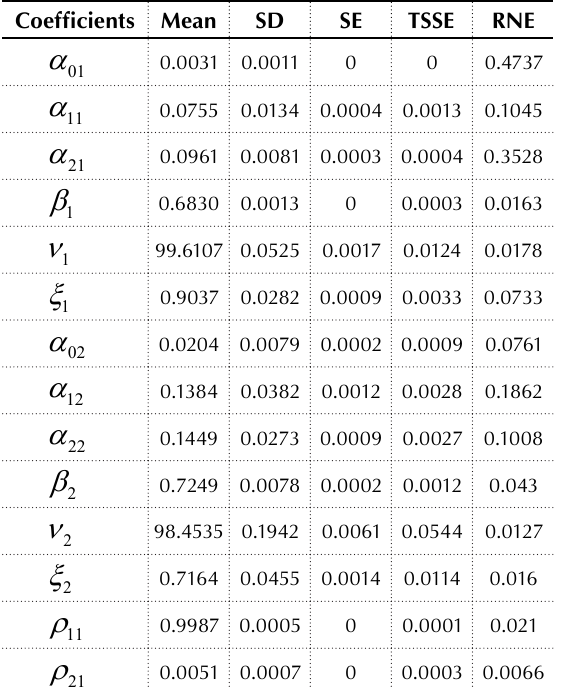
Table 3. Two-regime EGARCH with skewed Student t innovations